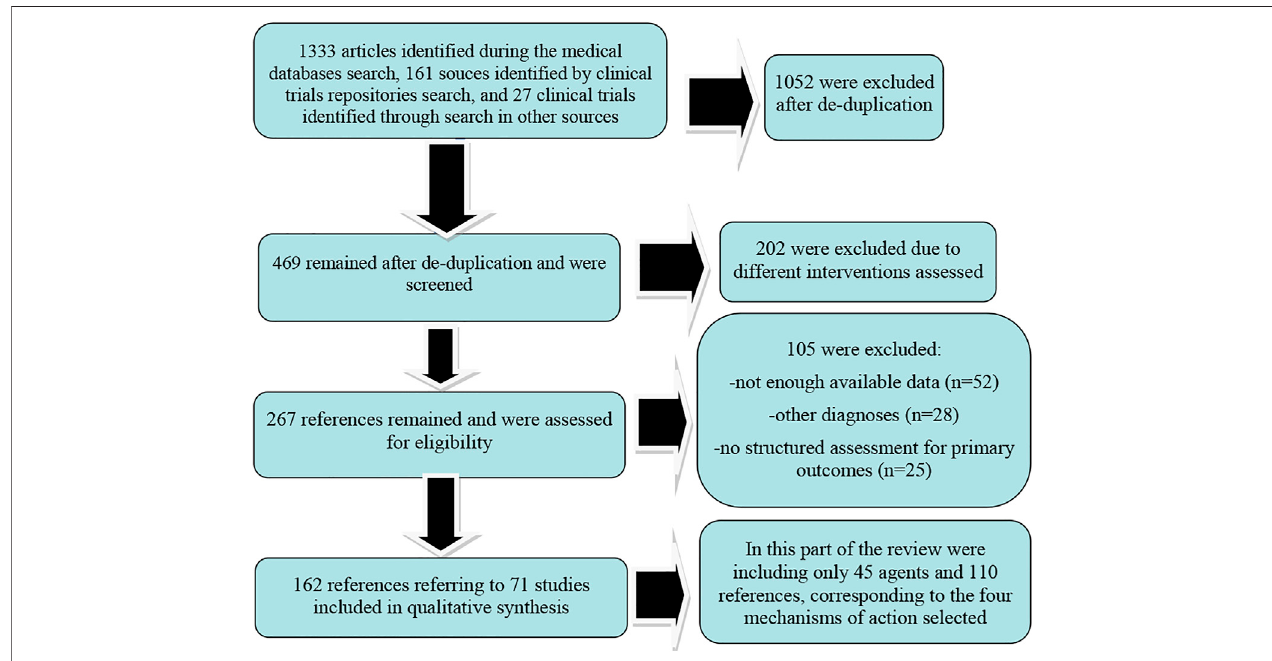
FIGURE 2 | Results of the PRISMA-based search